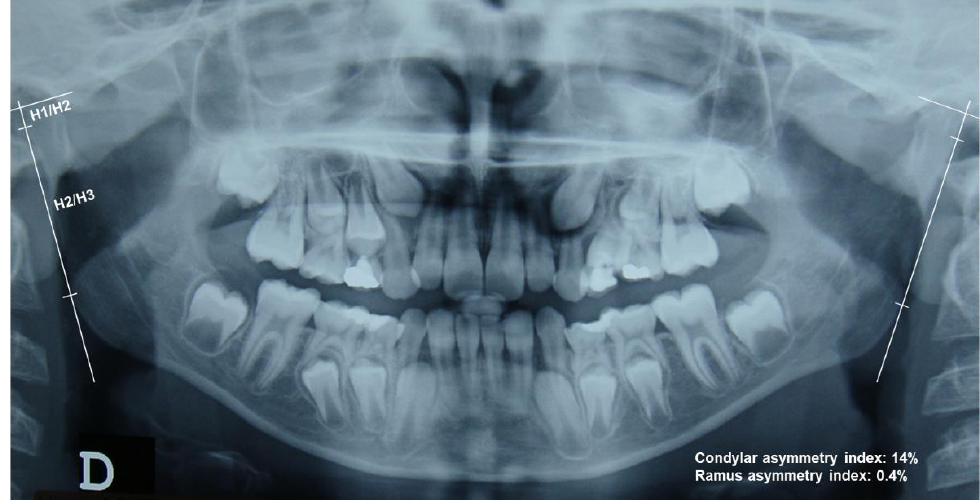
Figure 1. OPG of a mixed dentition patient with right unilateral posterior crossbite. The figure illustrates the use of the method by Habets et al., described in Materials and Methods. H1/H2 : height of the condyle; H2/H3 : height of the ramus. Note the condylar asymmetry between the sides. D refers to the right